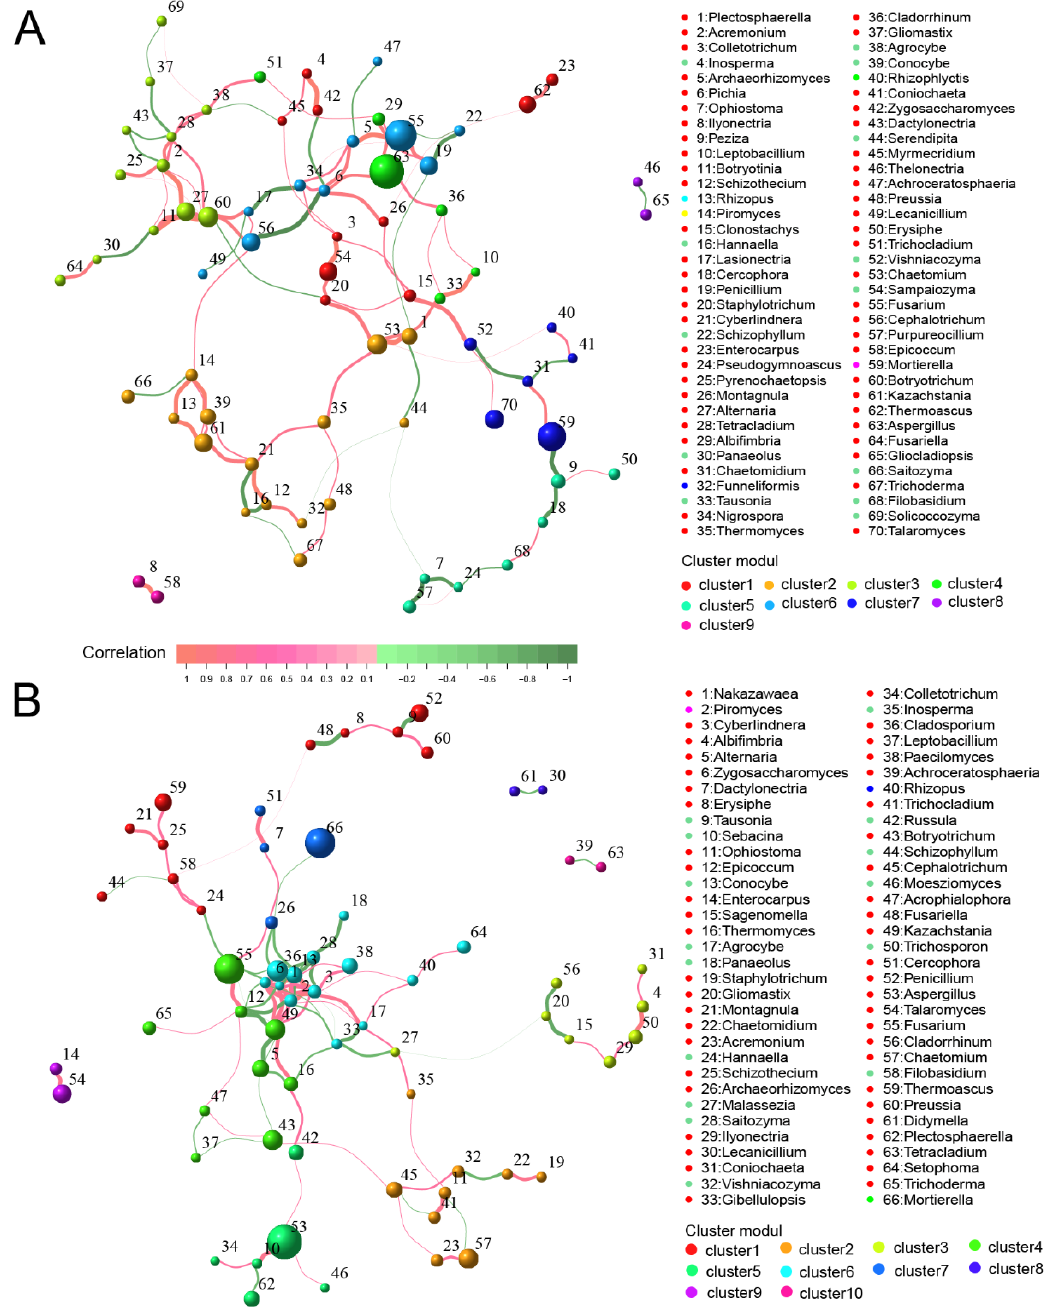
Figure 12. Co-occurrence network of fungi. Each node represents a type of bacteria. The size of the nodes represents the relative abundance of the fungi. The edges indicates the presence of an ecological correlation. The red edge indicates positive correlation. The green edge represents negative correlation. The thickness of the edge indicates the level of correlation. Bacteria of the same cluster are shown in the same color. The fungi names are shown on the right. ( A ) 0–20 cm soil. ( B ) 20–40 cm soil.